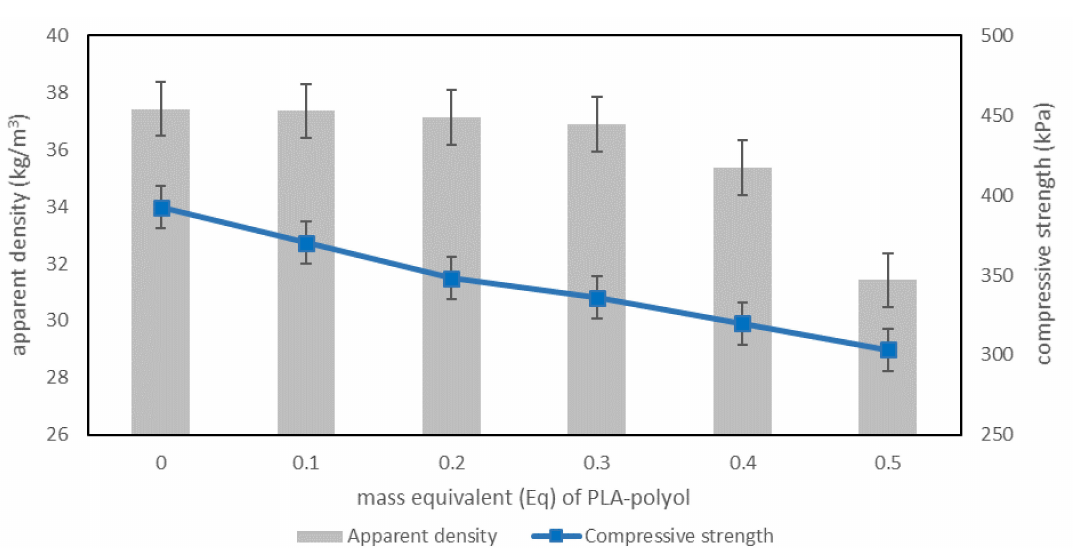
Figure 7. Dependence between polyol content, apparent density, and compressive strength in a direction parallel to growth of the